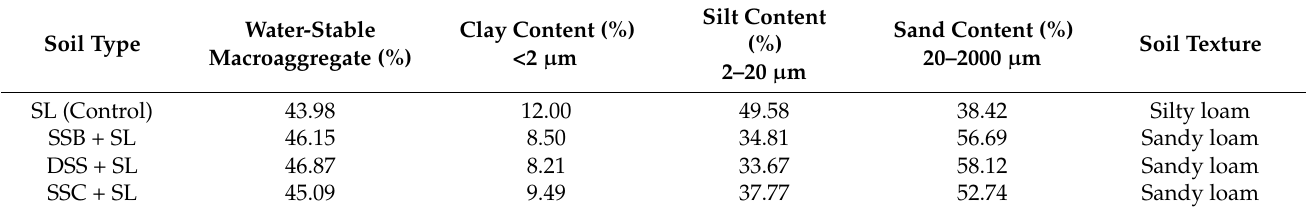
Table 4. Particle size distribution and texture grades of four different sample soils.